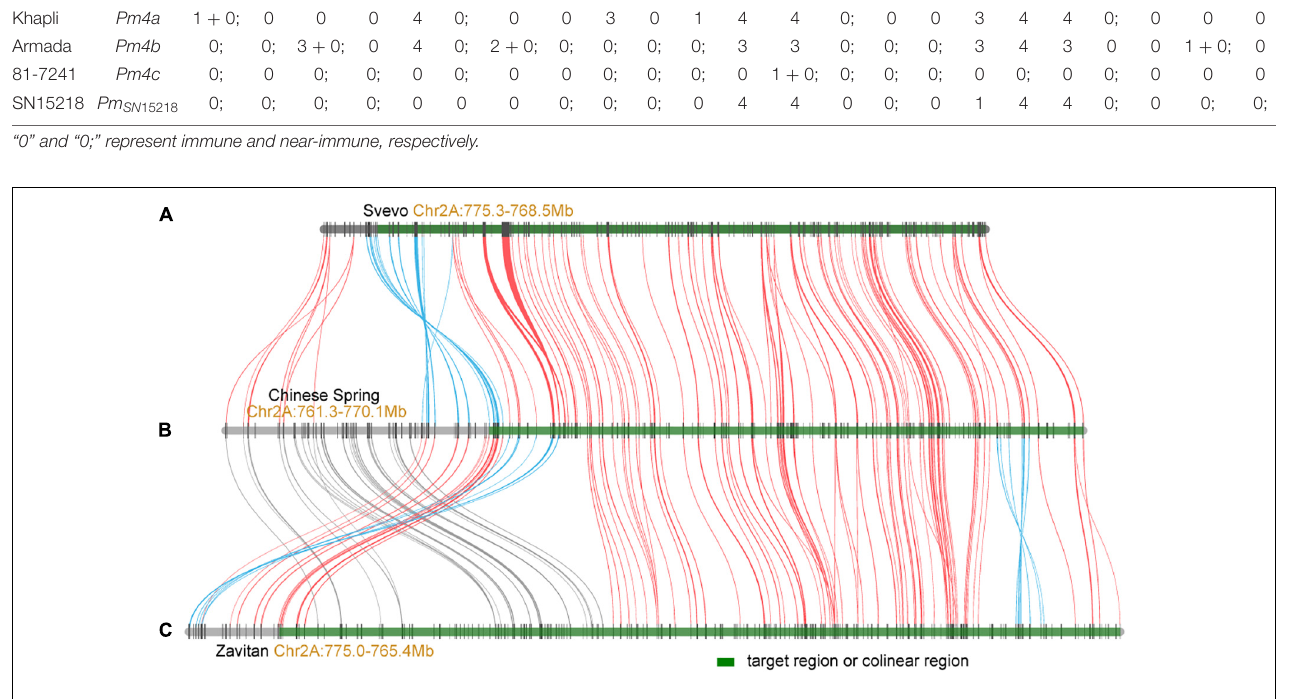
and 11 encode for receptor-like kinases or protein